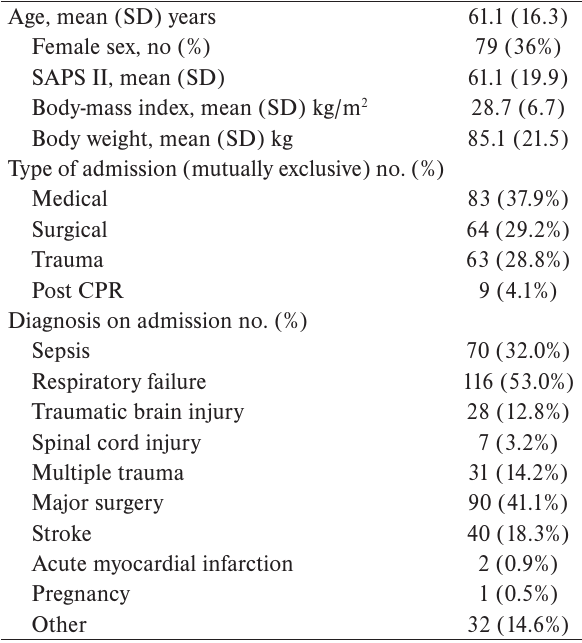
Table 1. Baseline characteristic of the patient